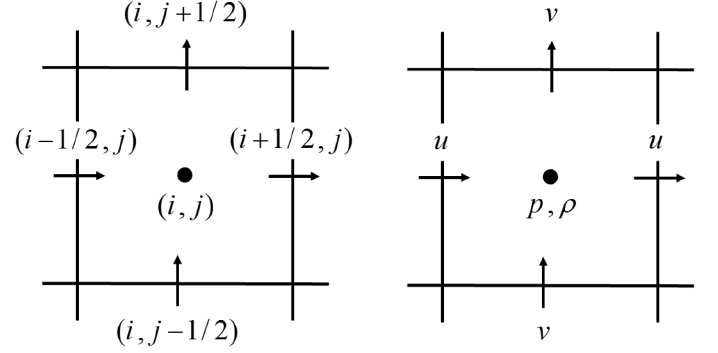
Figure 3. Staggered